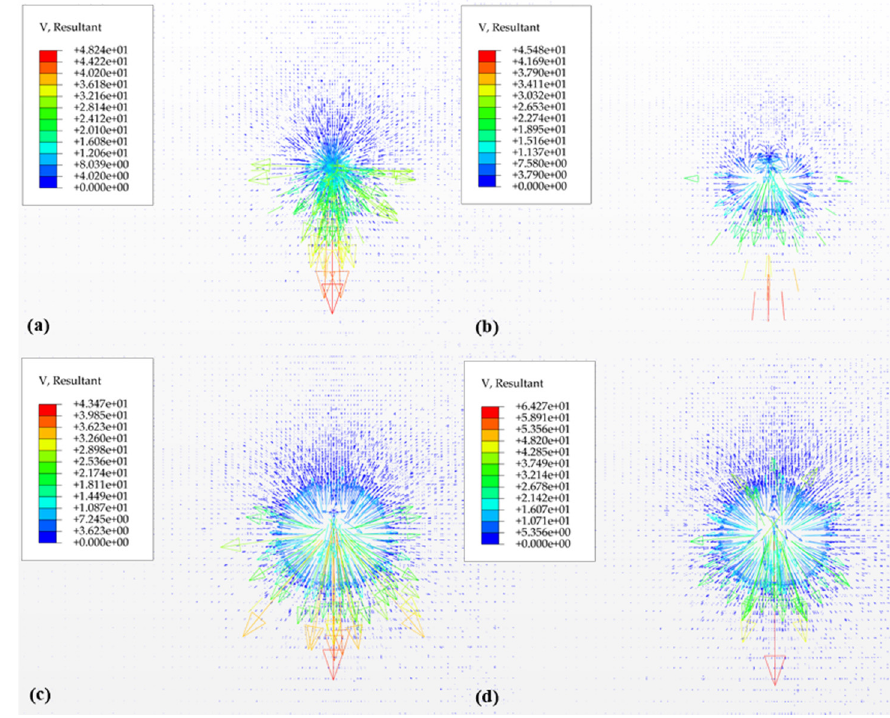
Figure 13. Velocity field in the bubble area during the collapse phase at: ( a ) t = 5.55 ms; ( b ) t = 5.60 ms; ( c ) t = 5.65 ms; and ( d ) t = 5.70 ms.